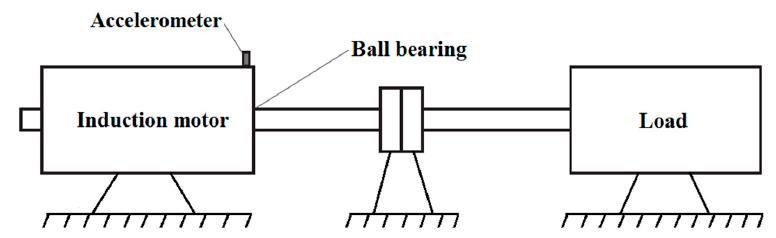
Figure 6. Experimental system.